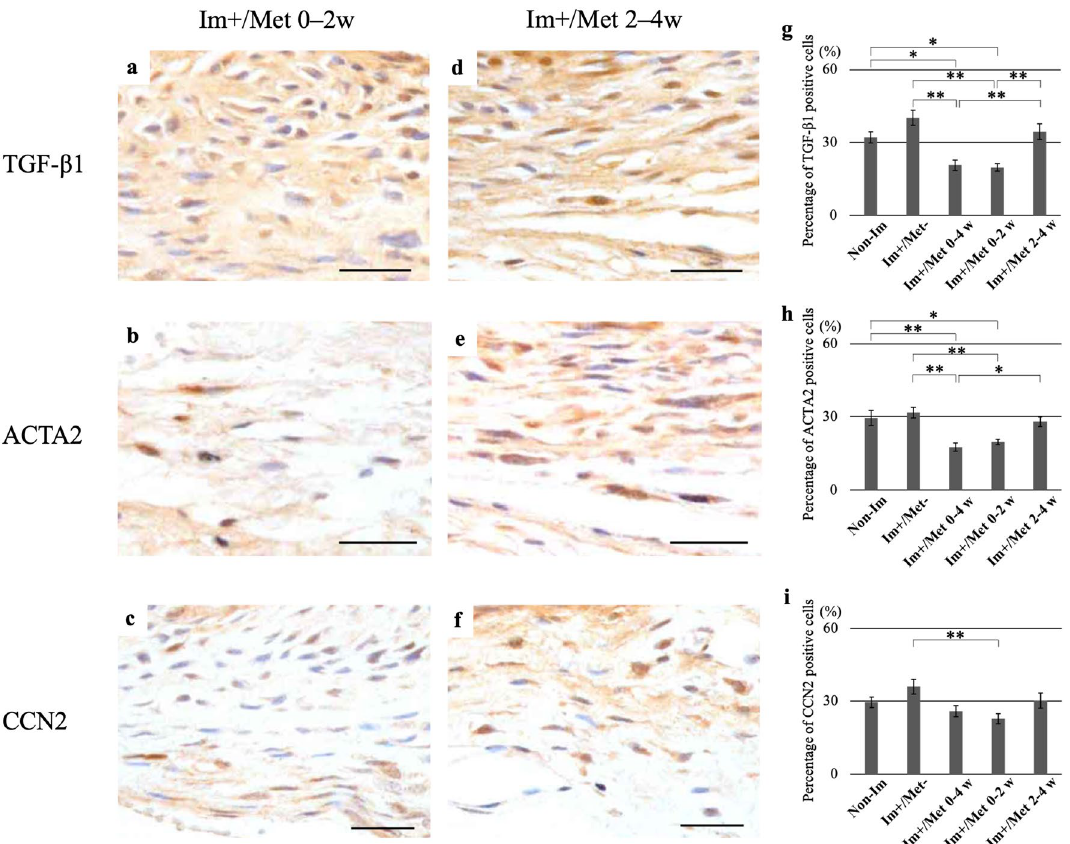
Figure 7. Immunohistochemical analysis for the effective time of metformin administration for joint capsular fibrosis. Immunohistochemical staining for TGF-β1, ACTA2, and CCN2 in the posterior capsule. Microscopic images of specimens immunostained for TGF-β1, ACTA2, and CCN2 with DAB and counterstained with hematoxylin in the (Im+/Met 0–2 weeks) group ( a – c ); and (Im+/Met 2–4 weeks) group ( d – f ) (Scale bar: 50 μm). Percentage of TGF-β1-positive cells ( g ), ACTA2-positive cells ( h ), and CCN2-positive cells ( i ) to the total number of cells in the posterior joint capsule. Data are expressed as the mean ± standard errors. *p < 0.05, **p < 0.01; n = 5. TGF-β1 transforming growth factor beta 1, ACTA2 actin alpha 2, CCN2 cellular communication network factor 2, Non-Im mice with non-immobilized knees, Im+/Met− mice with